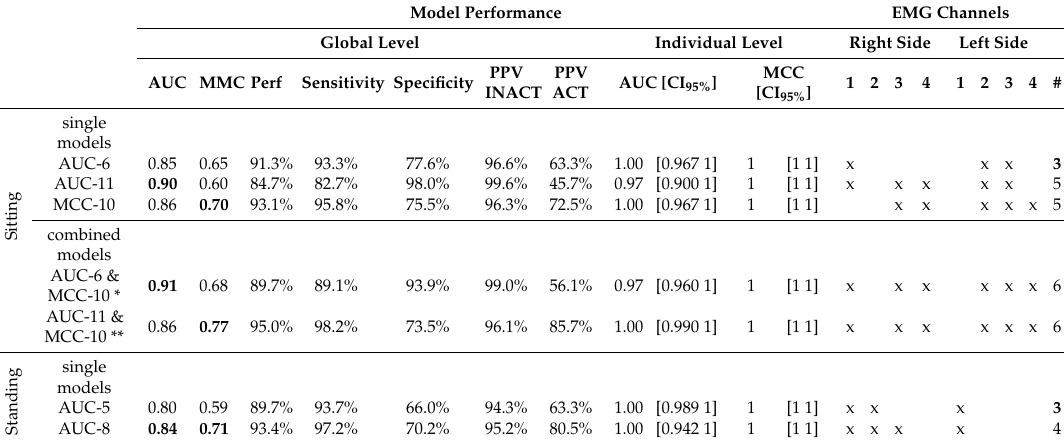
models predicts sedentary behavior, the minute is assigned to sedentary behavior. Abbreviations: AUC (Area under the ROC curve), MCC (Matthews correlation coefficient), Perf (Performance, percentage of correctly classified minutes), PPV (IN)ACT (Positive predictive value for (in)active